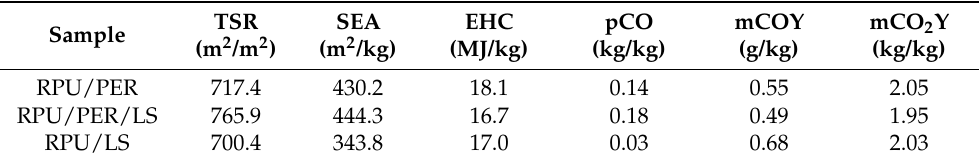
Table 4. Effect of LS as a char forming agent on gas transfer between the gaseous and con- densed phases.